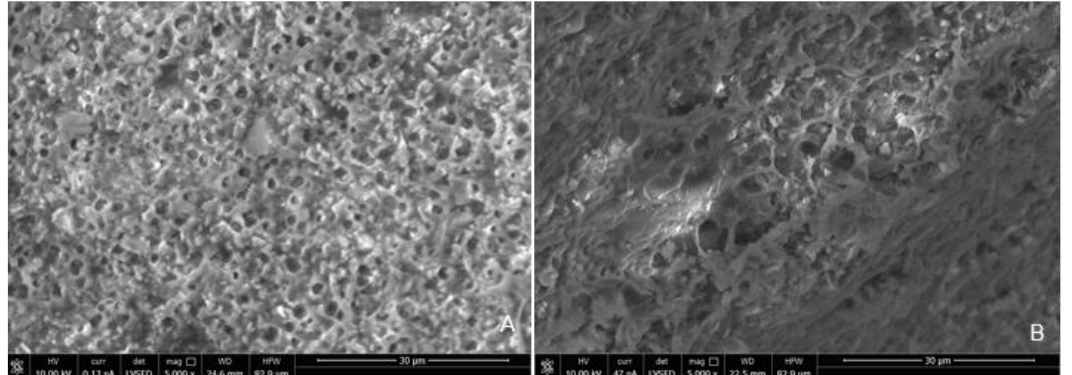
Figure 6. Scanning Electron Microscope Image of the Surface of the Tooth at Magnification 5000× Following Crown Removal with Rotary Handpiece ( A ) and Er,Cr:YSGG Laser ( B ).